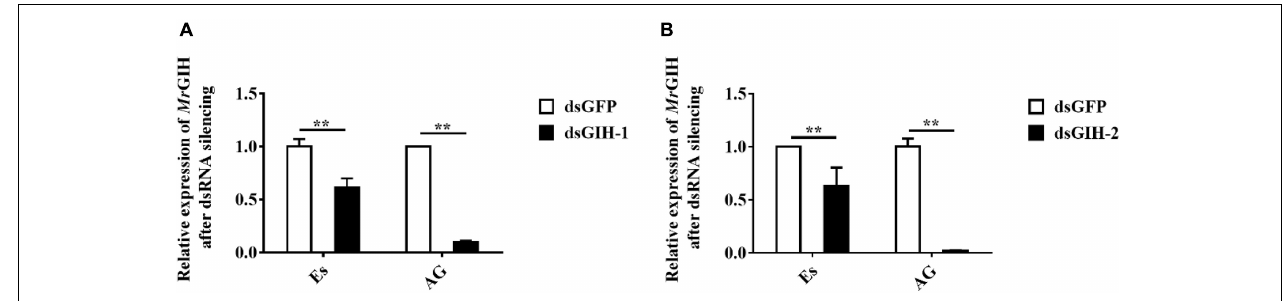
FIGURE 5 | The mRNA expression levels of Mr GIH after gene silencing. (A) The silencing efficiency of Mr GIH injected with dsMr GIH-1. (B) The silencing efficiency of Mr GIH injected with dsMr GIH-2, ** P < 0.001.